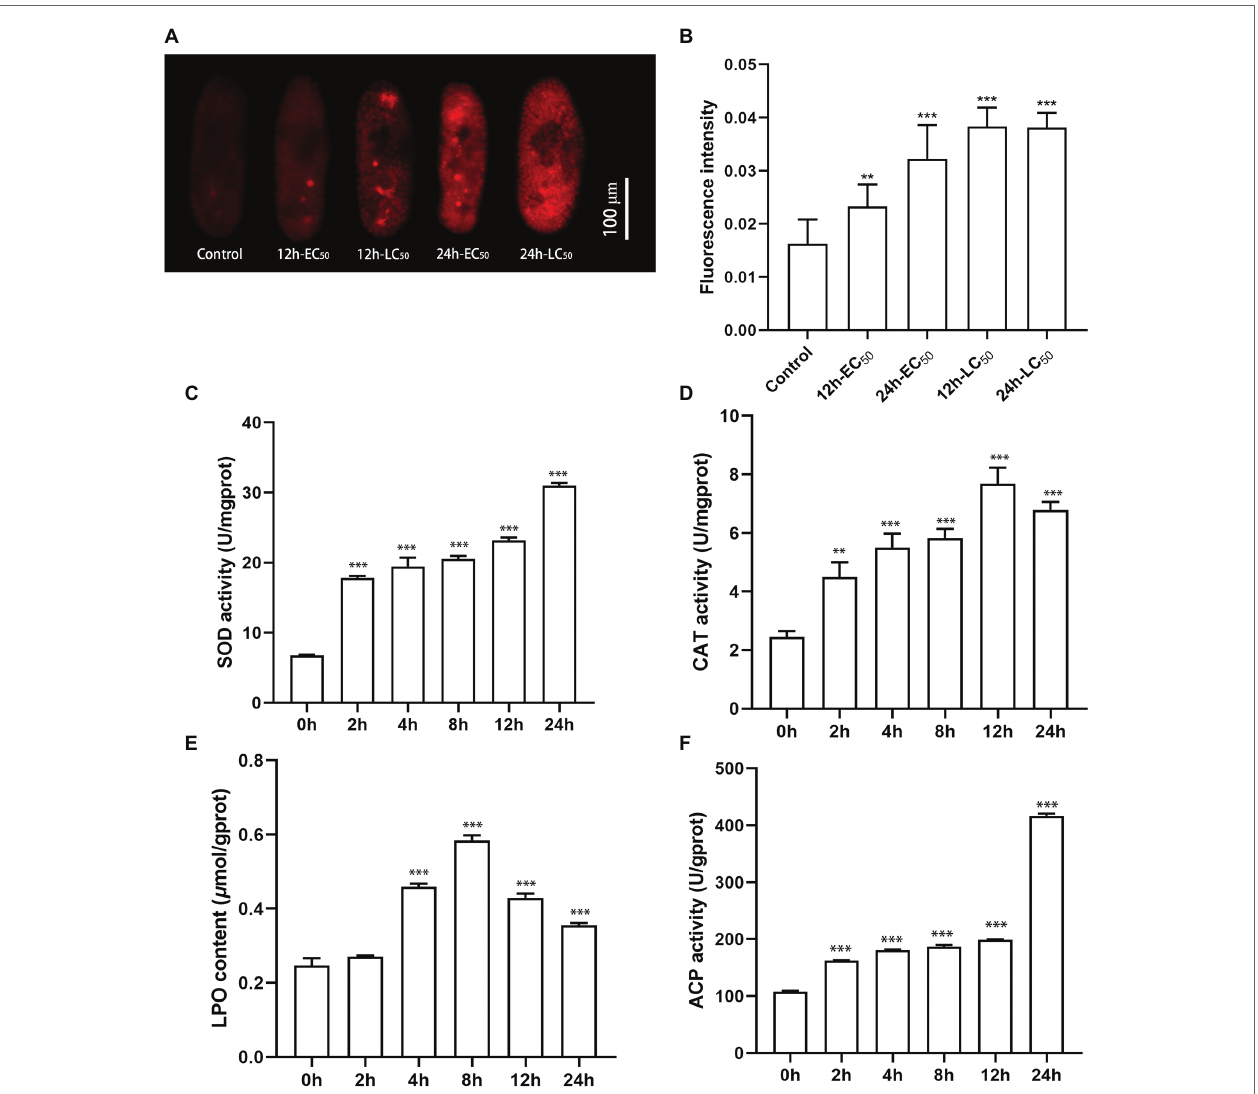
FIGURE 7 | The reactive oxygen species production and enzyme activities of Paramecium bursaria – Chlorella symbiotic system. (A,B) The fluorescence intensity of the DHE probe at different times and different exposure concentrations. (C–F) Accumulation of SOD activity, CAT activity, LPO content, and ACP activity under different CuNP exposure times. The statistical comparisons of means with 0 h were performed using one-way ANOVA. Significance levels are as follows: ** p < 0.01; *** p <